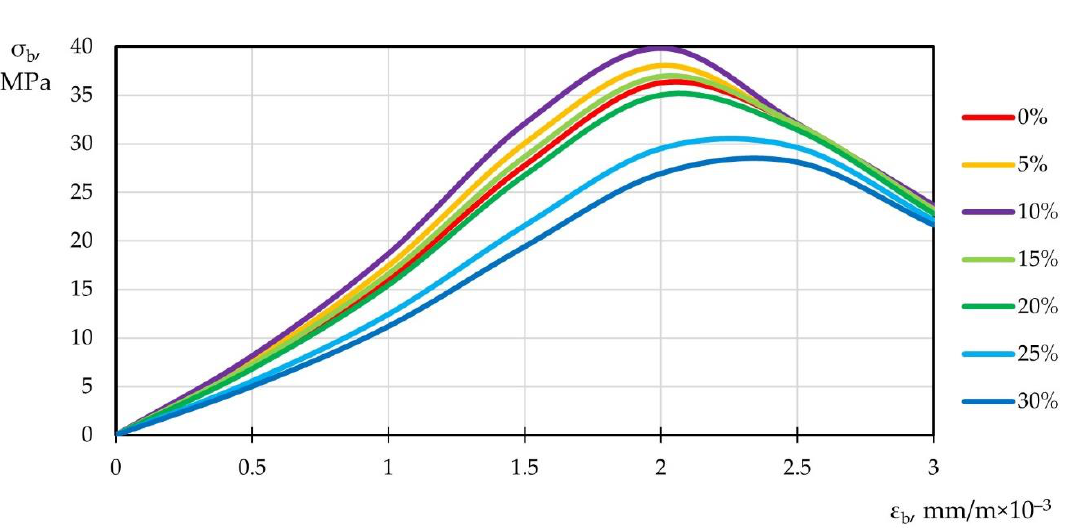
Figure 8. Tensile stress – strain diagram.